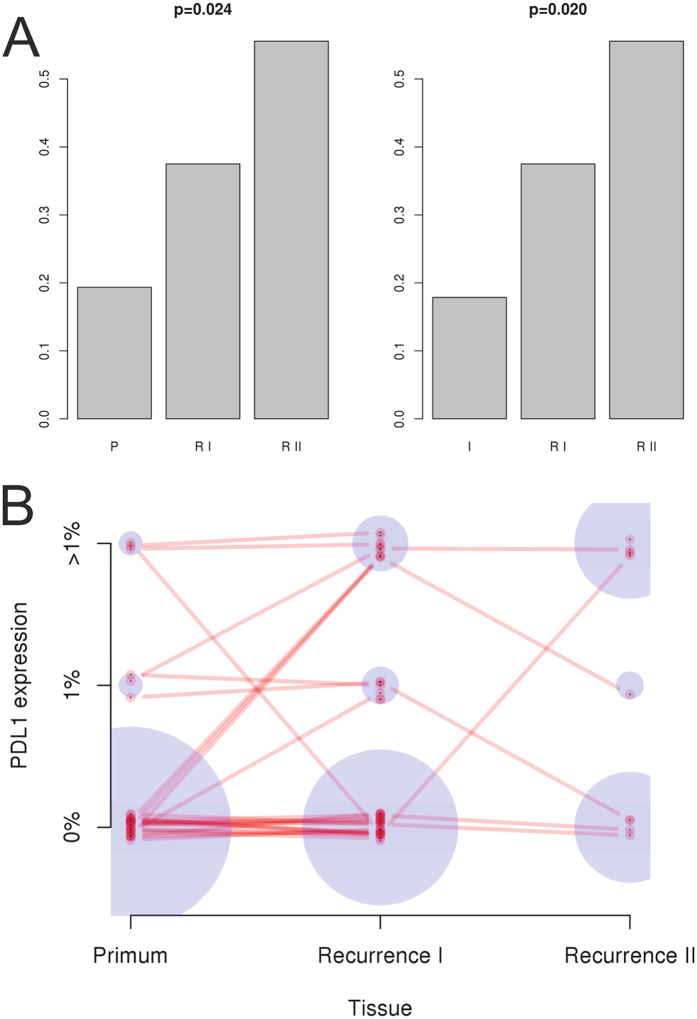
Course of PD-L1 expression in serous EOC comparing (A) primary tumor tissues of the ovary (P) or metastatic peritoneal implants (I) to tumor recurrences (first recurrence, RI or second recurrence, RII) (y-axis, ratio of positive cases) and (B) a scheme showing the course of PD-L1 abundances of all samples individually, connected if samples are from the same patient (blue circles represent relative frequencies at each position).